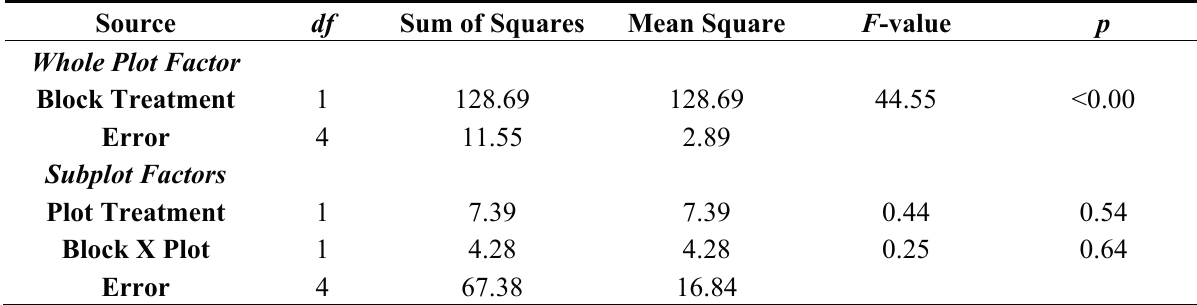
Table 1. Split-plot analysis of variance for the Three-dimensional Vegetation Density Index (3DI). Block Treatment is Thinning and Burning/untreated, Plot Treatment is Grazed/ungrazed. Note that the mean of two 3PI values were used in the ANOVA, computed using two separate scans within each replicate.